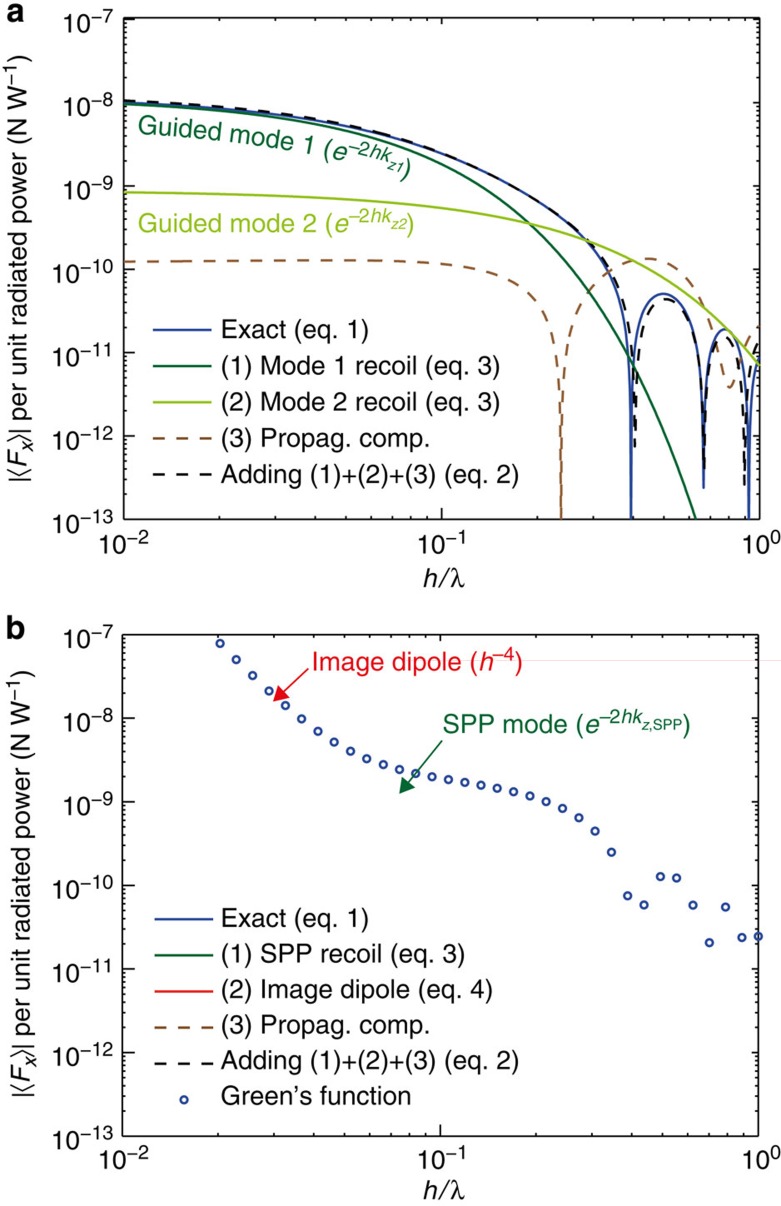
Distance dependence of the time-averaged lateral force.A circularly polarized dipole p=[1,0,i] above (a) a dielectric slab (n=3.45) of thickness t=0.135λ resting on a substrate (n=1.45) and (b) a gold substrate (ɛ2=−11.8+1.23i at 632.8 nm). The exact result from equation (1) and the different terms in the approximation are shown. Note: for the calculation of Rk we used Δ1=0.3neff,1, Δ2=0.15neff,2 and ΔSPP=0.1neff,SPP. The results of the Green function evaluation are also shown in b. Results based on numerical simulations of the same scenarios are shown in Supplementary Note 5.